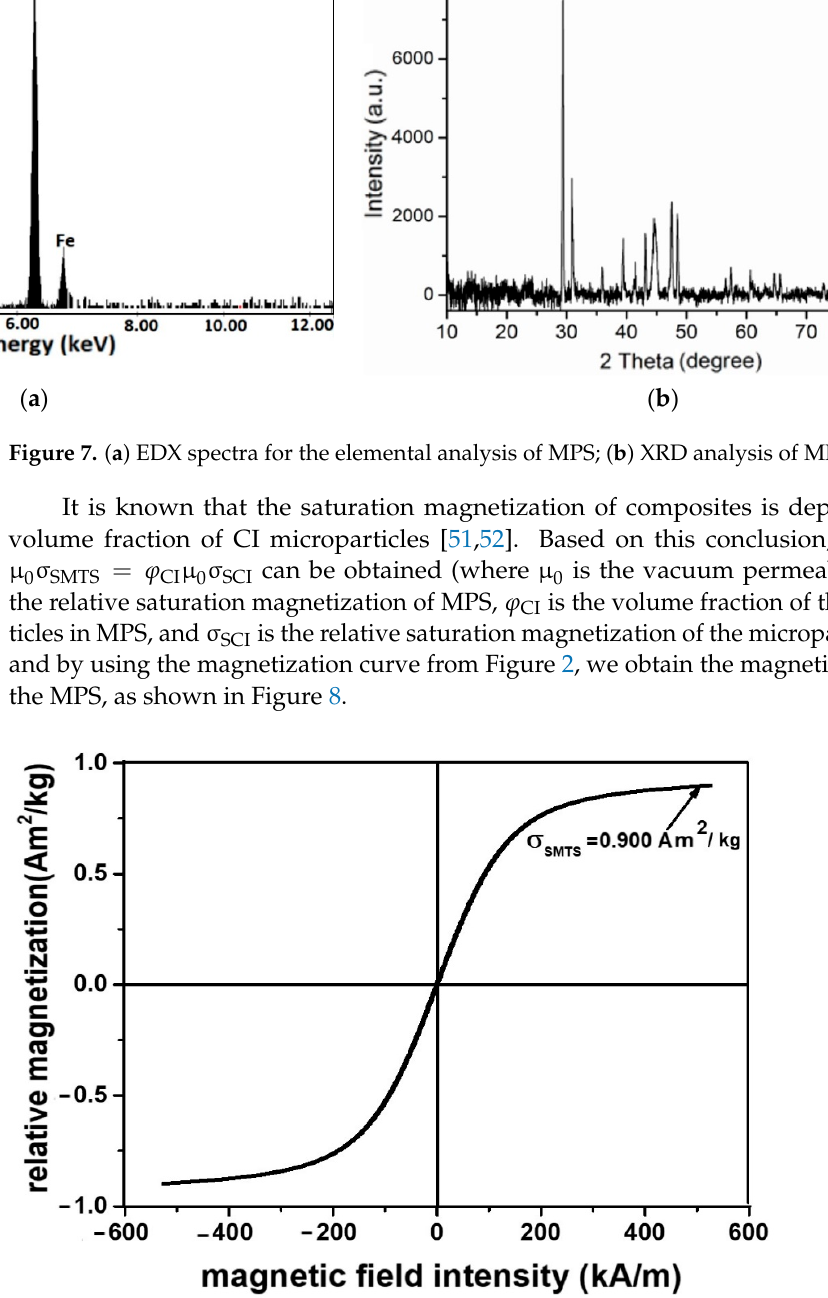
Figure 8. Magnetization slope for the MPS. It can be seen from Figure 8 that the MPS magnetization slope has the same shape as that of the CI microparticles. However, due to the volume fraction of the CI microparticles, i.e., value 𝜑 (cid:3004)(cid:3010) = 0.46 vol% , the saturation magnetization of the MTS sponge is 266 times lower compared with that of the CI microparticles from Figure 2. The adhesive part of the CS is applied on the faces of the MPS by rolling. At the end of this step, the MTS device from Figure 9 is obtained. ( a ) ( b ) Figure 9. ( a ) Front view photo of the MTS; ( b ) lateral view photo of the MTS (1, copper foil; 2, MTS; 3, electrical connection). It can be seen from Figure 9 that the MTS device has a stable mechanical configura- tion and is provided with copper wires for electrical connections. The copper foil with a thickness of 0.05 mm is molded on the rough surface of the MTS sponge, which explains the unevenness, shown in Figure 9, on the faces of the MTS. 2.3. Experimental Set-Up and Measurements The experimental set-up for the study of the MTS in a magnetic field superimposed with the action of the mechanical force field is shown in Figure 10.